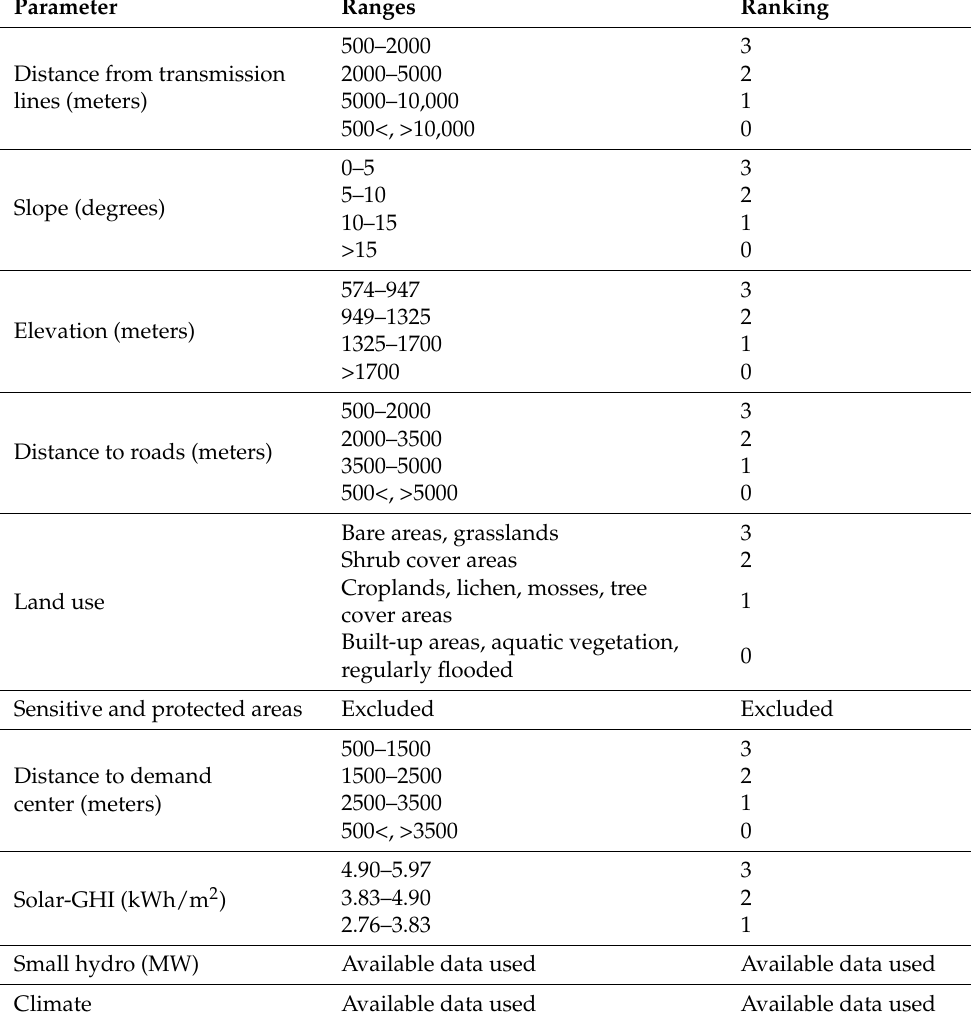
Table 1. Ranking of the